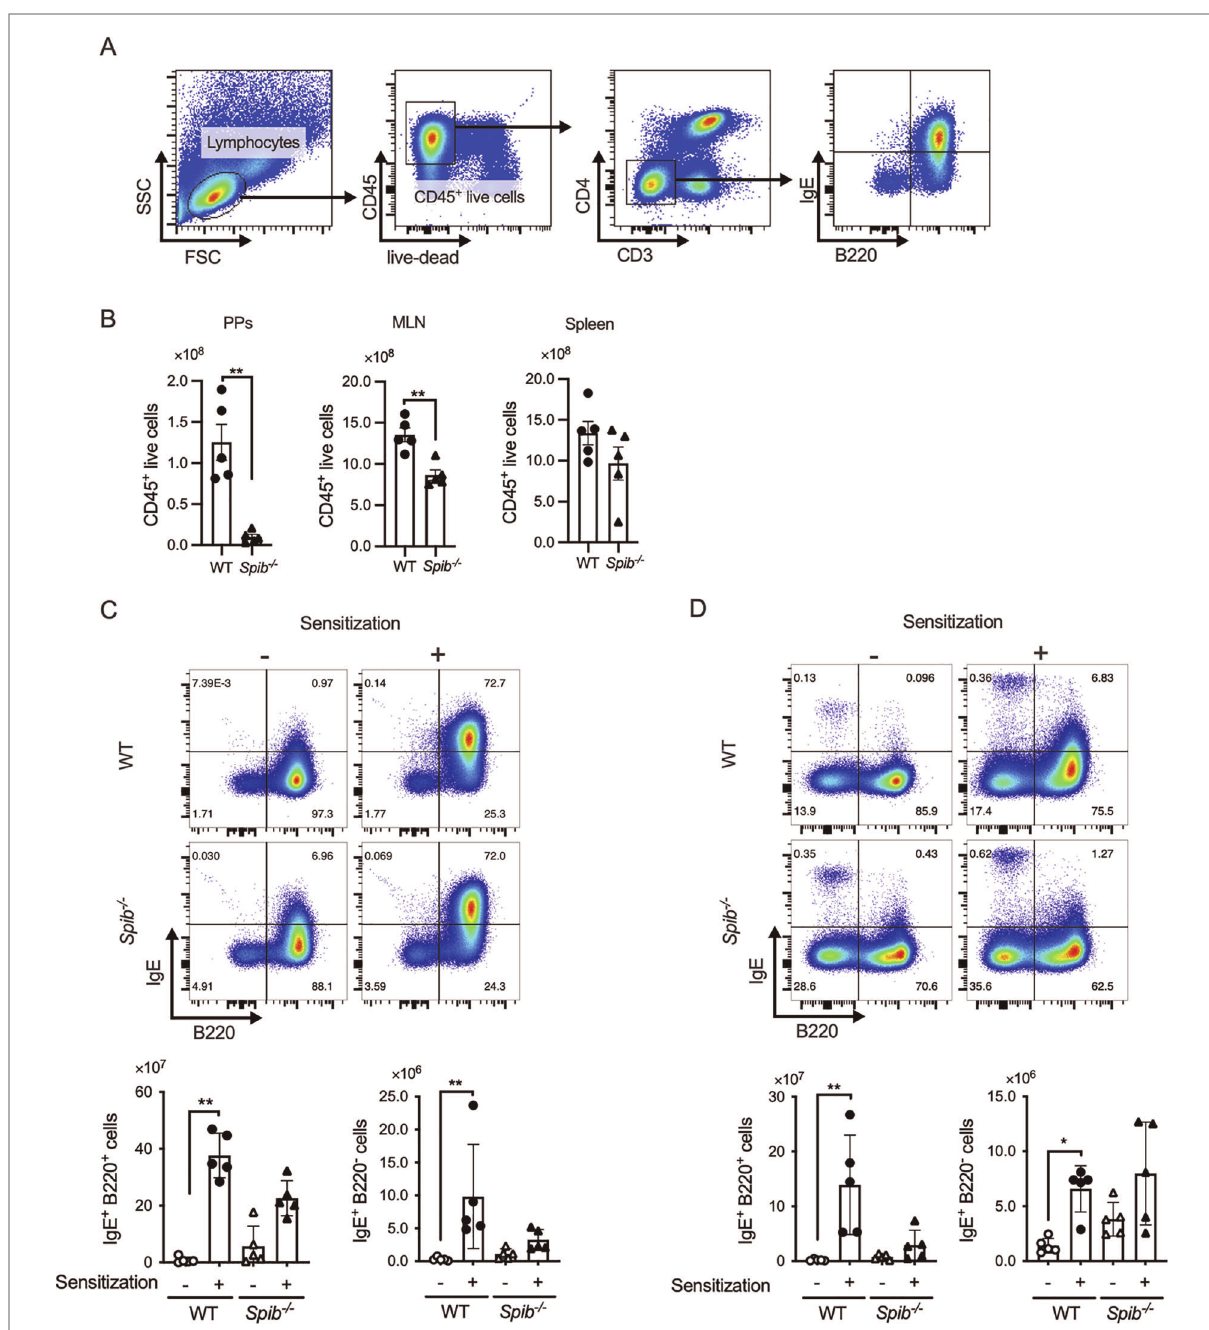
FIGURE 2 Splenic IgE + cells are responsible for IgE production in Spib − / − mice. ( A ) Gating strategy of CD3 − CD4 − CD45 + live lymphocytes. ( B ) The numbers of CD45 + live lymphocytes of Peyer ’ s patches (PPs), the mesenteric lymph node (MLN), and the spleen from OVA-sensitized mice (day 20). ( C,D ) The CD3 − CD4 − 7-AAD − CD45 + cells were further divided into IgE + B220 − and IgE + B220 − cells. The bar graphs show the number of IgE + B220 − and IgE + B220 − cells in the MLN ( C ) and the spleen ( D ). Representative data from at least three independent experiments are shown. Data are expressed as mean±SEM ( n =5 or 6). * p <0.05, ** p <0.01, calculated by unpaired t -test for B and Kruskal – Wallis test for C,D